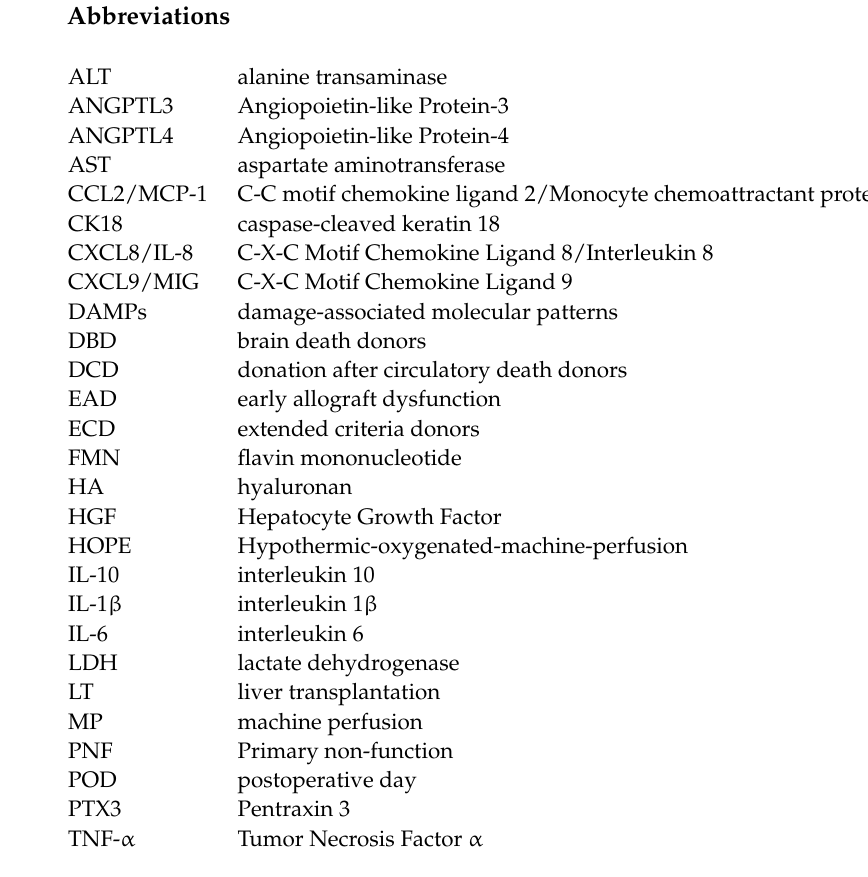
Table S2: Differences in the molecular profile of effluent fluids of livers from the “EAD-no” and the “EAD-yes”